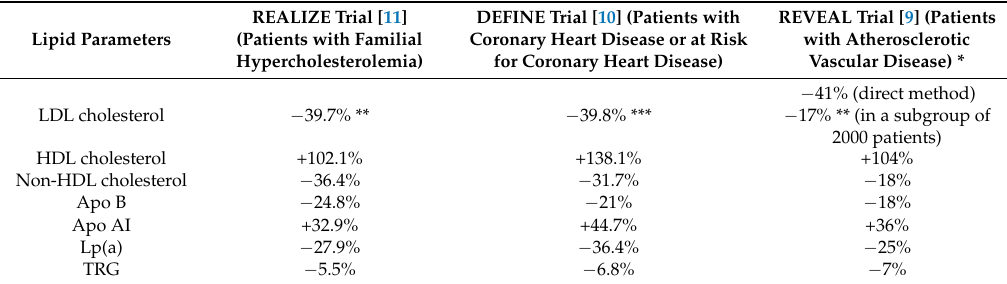
Table 1. Anacetrapib (100 mg/d)-associated percentage changes of lipid parameters versus placebo in randomized clinical